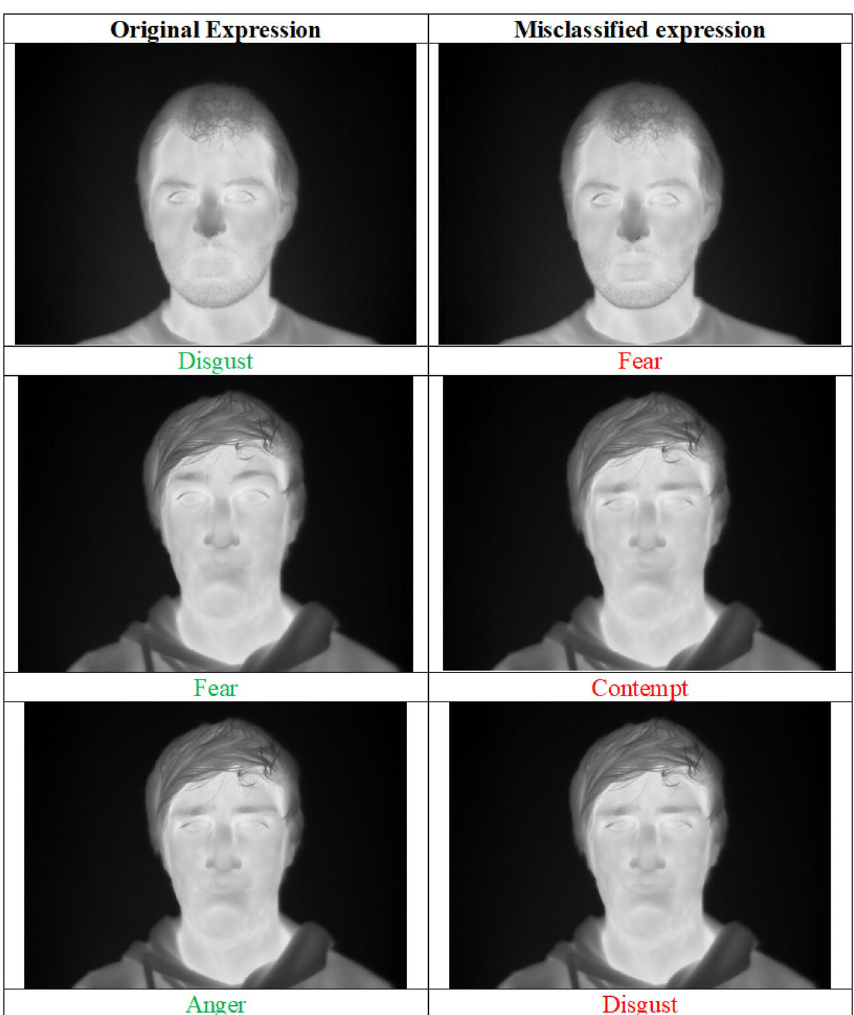
Figure 12. Some confusing facial expressions. The original expressions are marked in green color and the corresponding misclassified pair is marked in red. Image is developed using Draw.io 32 .